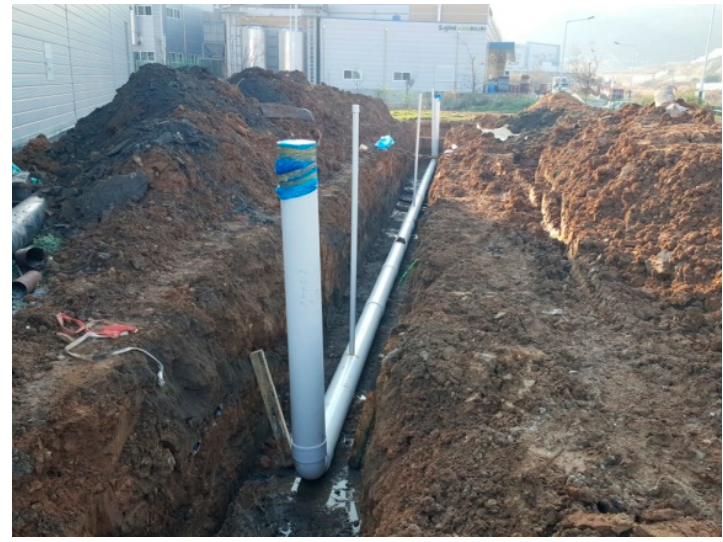
Figure 3. Ground ‐ to ‐ air heat exchanger field test ‐ rig. Figure 3. Ground-to-air heat exchanger field